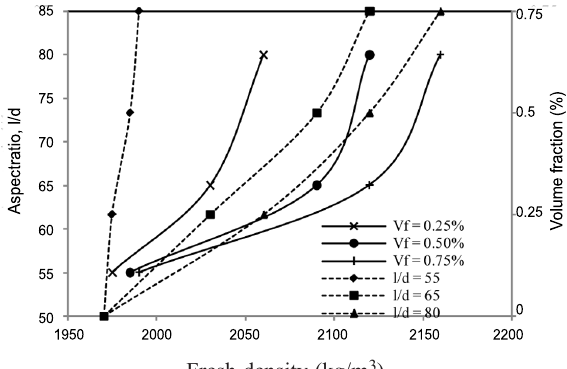
Fresh density (kg/m 3 Fig. 3. Influence of aspect ratio (l/d) and volume fraction on fresh density